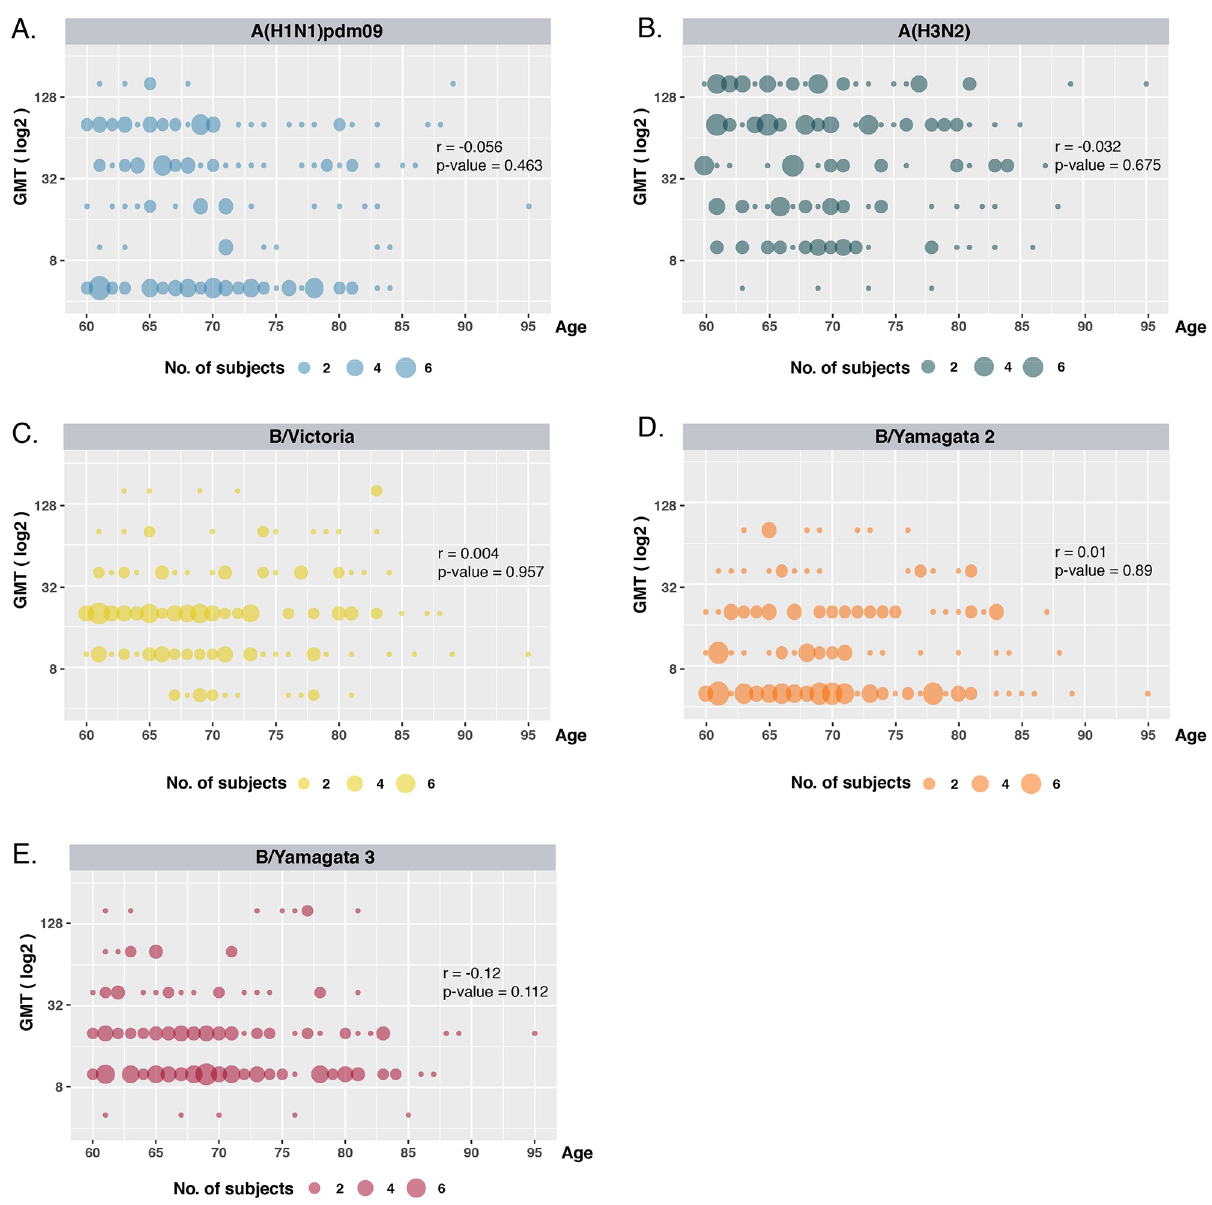
Fig 2. Correlation between age and antibody titers for influenza A and B viruses among the elderly. The Spearman rank correlation was conducted to identify the relationship between the age of individuals and the geometric mean titers (GMT) for individual influenza type or subtype. (A) influenza A/H1N1pdm09(blue); (B) influenza A/H3N2 (green); (C) influenza B/Victoria (yellow); (D) influenza B/Yamagata 2(orange) and (D) influenza B/ Yamagata 3 (pink) are indicated. The X-axis shows the age range from 60 to 95 years old. The Y-axis indicates the geometric mean titers (GMT) with a logarithm scale. The size of the circles corresponds to the number of